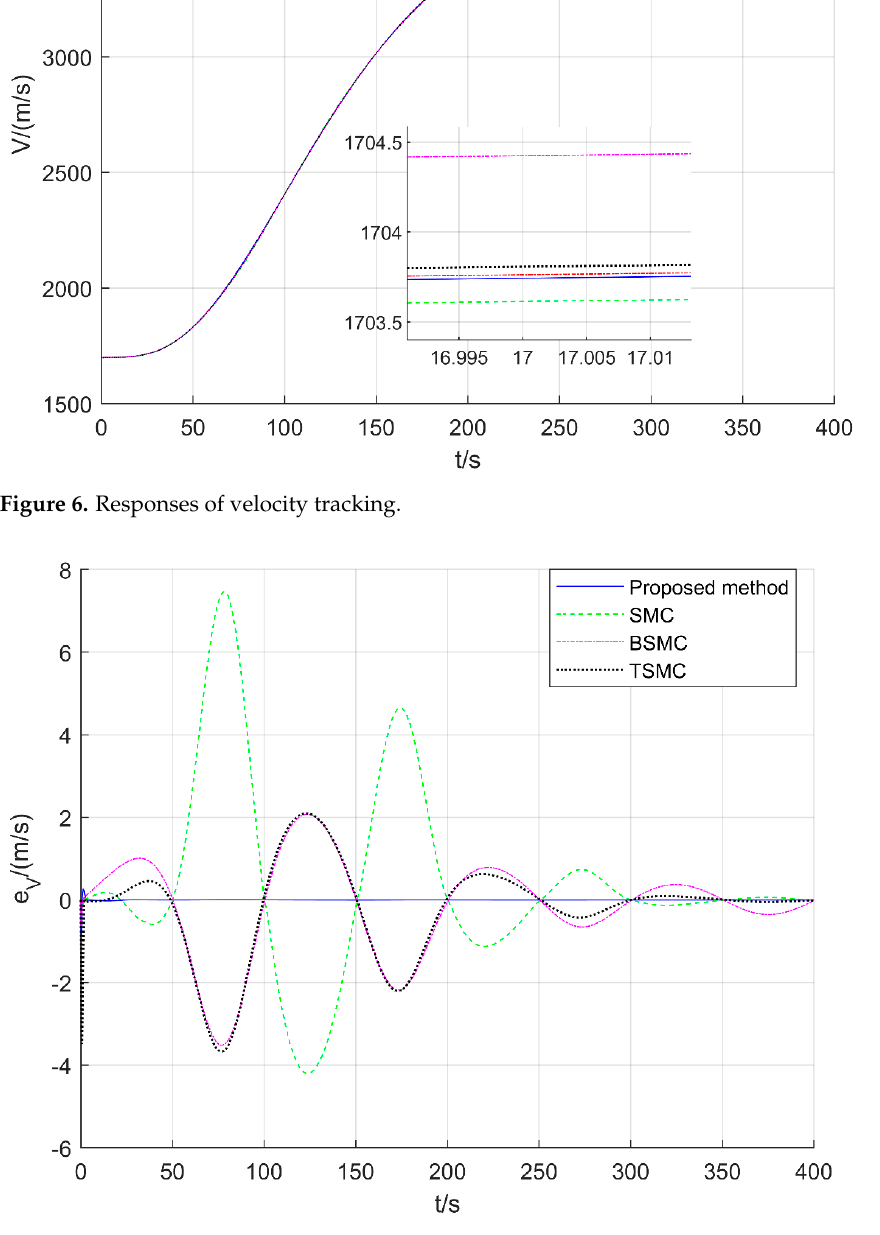
Figure 8. Responses of altitude tracking.